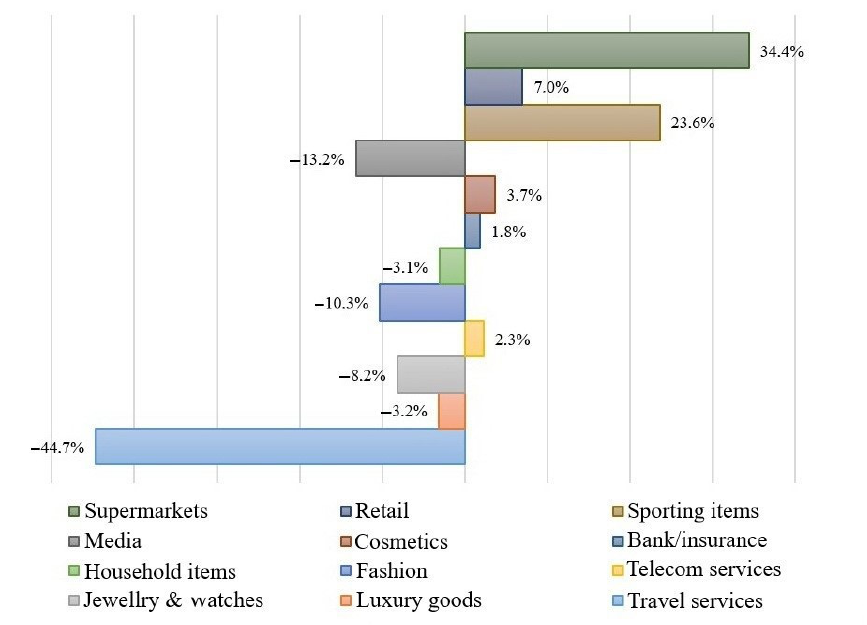
Figure 2. Effects of COVID-19 on global e-commerce by industry. Estimated average per cent change